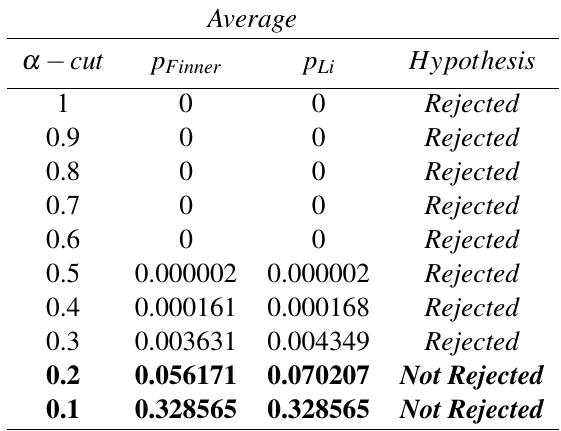
Table 4: Results of the Finner and Li test in the comparison between α −